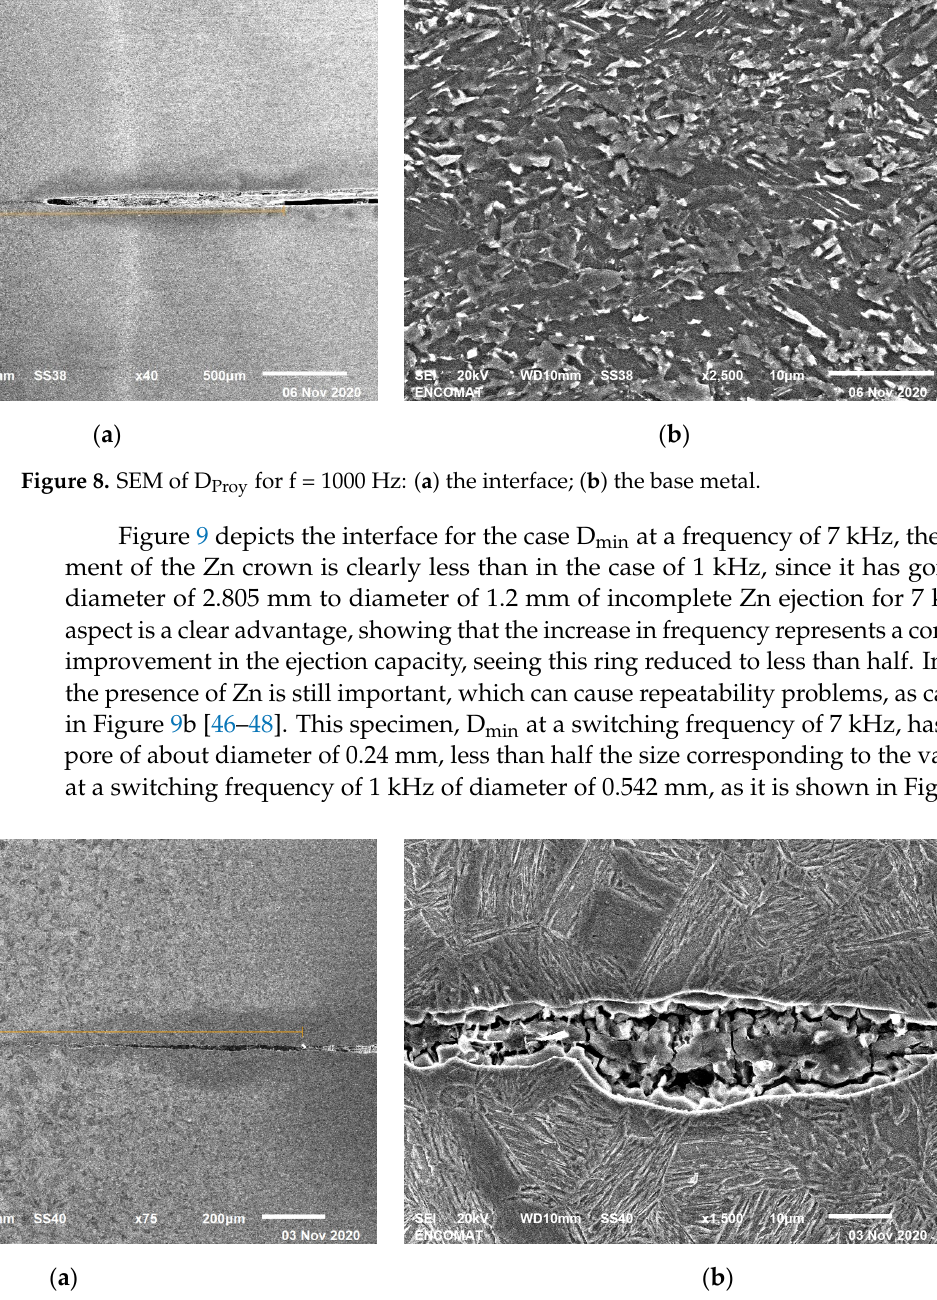
Figure 10. SEM of D Proy for f = 7000 Hz: ( a ) the interface ( b ) detail of Zn in the interface. 3.4. Weld Spot Diameter The diameter of the weld spot is one of the most used quality criteria in the industry. Figure 11 shows the evolution of the size of the welding spot as a function of the welding current for both frequencies, keeping welding time and welding force constant. The points corresponding to the means of the diameters, the deviation for each point and the trend lines are displayed. The vertical lines correspond to the interpolated current values to es- tablish the functionality and quality of the welded joints. They were obtained from the diameter–current graph, considering the trend lines of the point clouds and the cut-off value for D min , F ok and D ok . D min is the current value for which, of the series of welds carried out, half plus one of the measured diameters is less than the minimum diameter; D proy corresponds to the current value, for which the series of welded specimens has projections in most of them; D ok corresponds to the current value corresponding to the diameter con- sidered optimal by the regulations and F ok is the current value for which the value of F m considered optimal is reached, on average. The lines corresponding to both frequencies of all these significant values were represented. F ok and D proy coincide for both frequencies, in the case of D min and D ok , and is slightly higher in both cases for 7 kHz. Two stages in the evolution of spot diameter with welding current can be clearly distinguished: growth and stabilization. The almost linear relationship between the two parameters during the initial period has been reflected by numerous authors [21,25,50]. During this period, nugget growth occurs as more energy is supplied to the joint. As can be seen, the maximum diameter reached is independent of the switching frequency, but